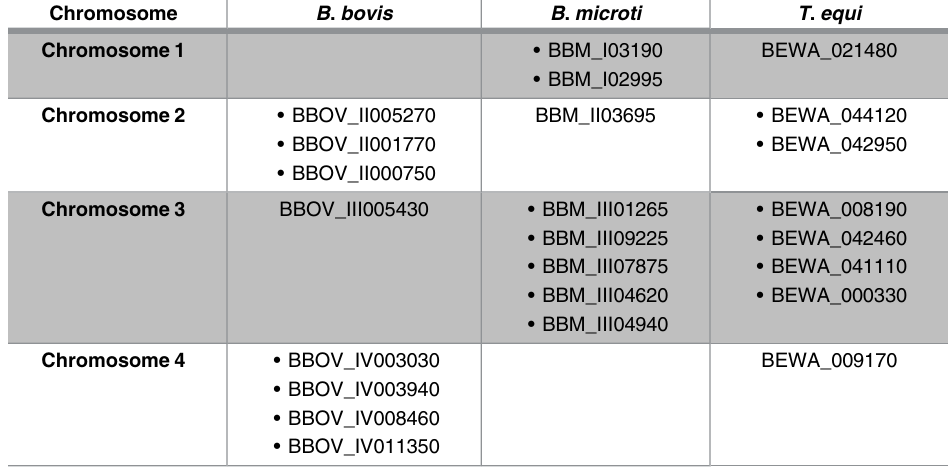
Table 3. Myb genes distribution among B . bovis , B . microti and T . equi genome.